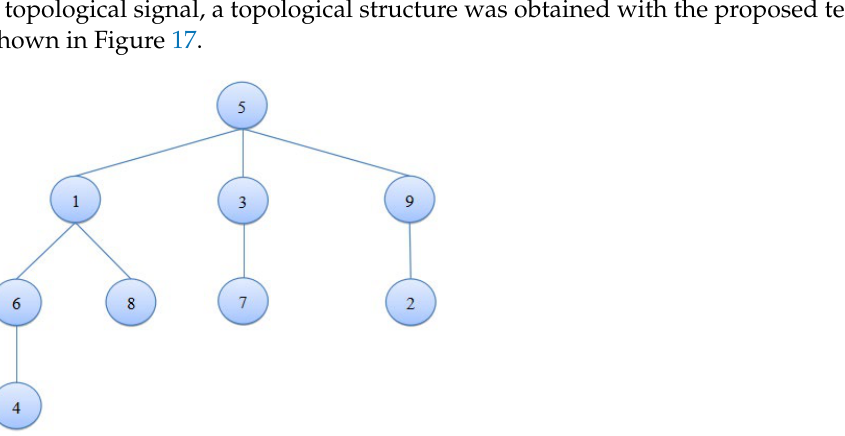
Figure 17. Topological structure obtained with proposed technique. (1~9 means nine measurement switches).